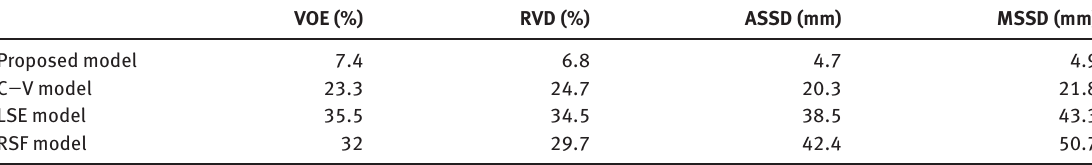
Table 2: Average VOE, RVD, ASSD, and MSSD for the Proposed Models and Existing Algorithm Using MRI Scan. VOE (%) RVD (%) ASSD (mm) Proposed